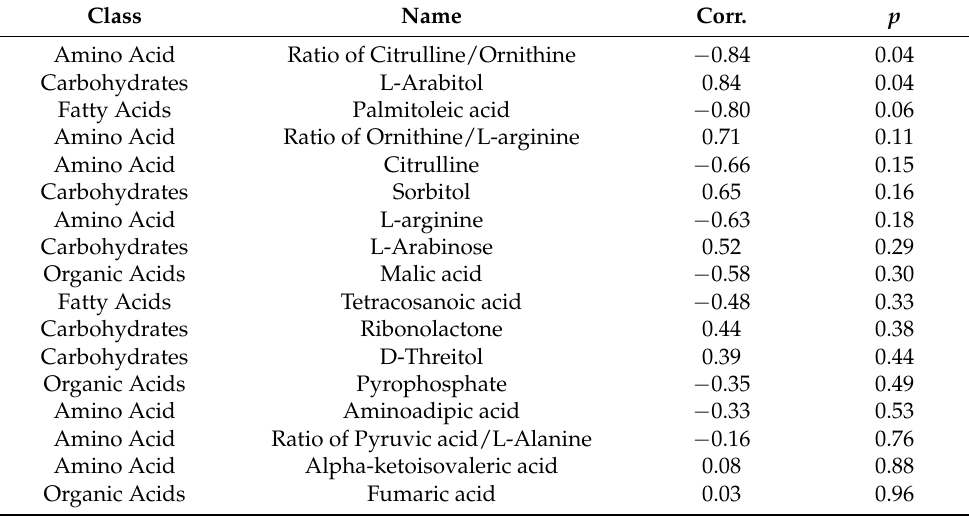
Table 2. Coefficients between significantly altered metabolites and serum eosinophilia